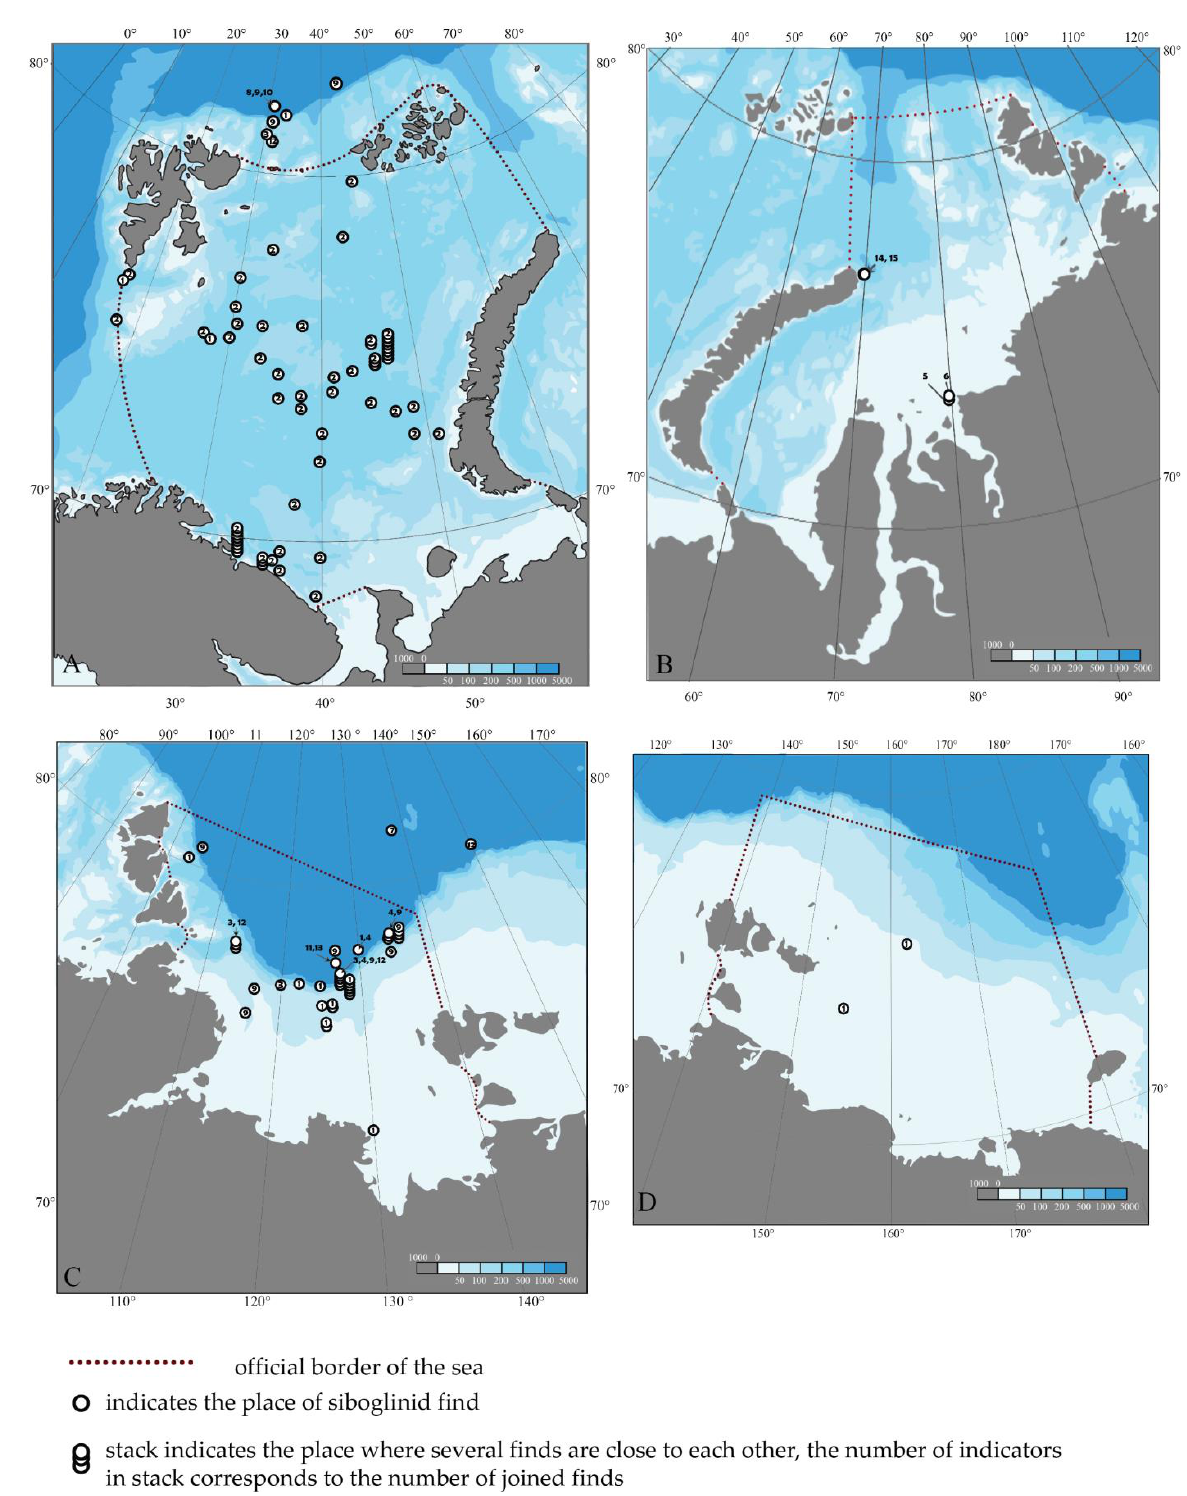
Figure 1. Distribution maps of siboglinid records in the Arctic seas of Russia. ( A )—the Barents Sea, ( B )—the Kara Sea, ( C )—the Laptev Sea, ( D )—the East Siberian Sea. The numbers indicate the records of the following siboglinid species: 1— Oligobrachia haakonmosbiensis , 2— Nereilinum murmanicum , 3— Nereilinum squamosum , 4— Polarsternium rugellosum , 5— Crispabrachia yenisey , 6—